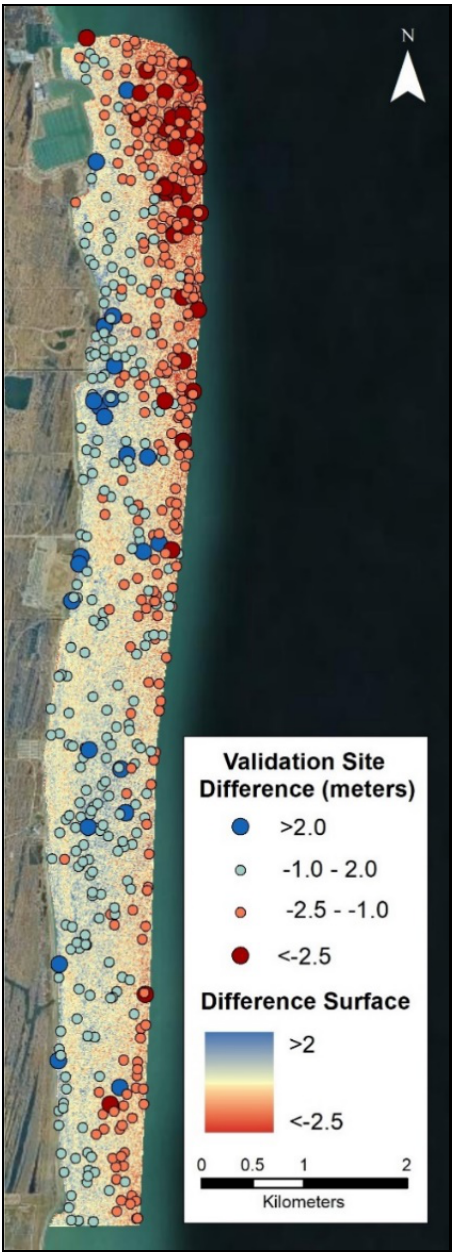
Figure 23. Map comparison of SDB generated from Sentinel-2 imagery to airborne bathymetric lidar point cloud (30 cm vertical accuracy), highlighting the tendency for the SDB to overestimate depths offshore (red sites, making it appear deeper) as opposed to underestimate depths nearshore (blue sites, making it appear shallower). Note that validation points within the RMSE range of ± 1.02 m were removed from the map